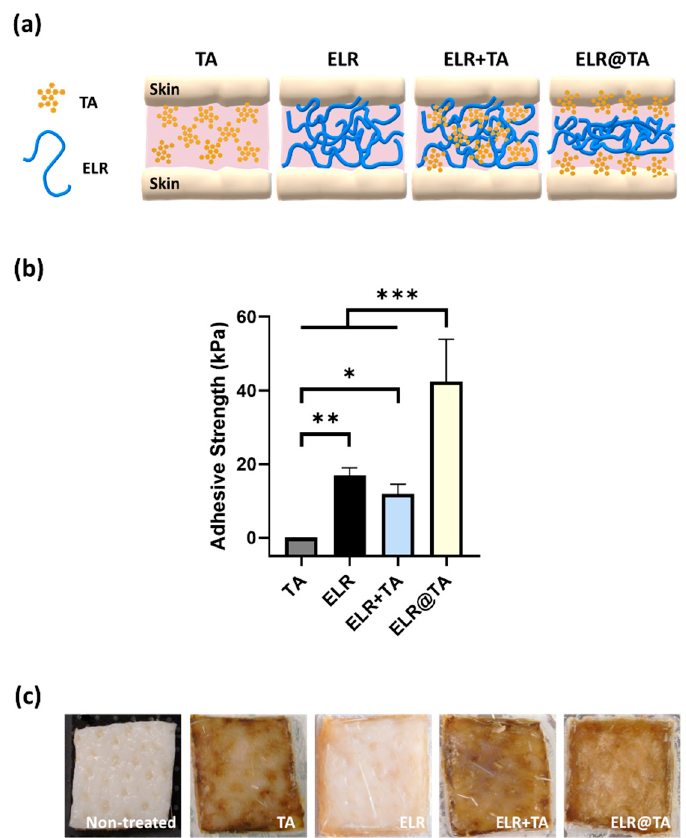
Figure 4. Evaluation of the adhesiveness of ELR-based bioadhesives on skin tissues. ( a ) Schematic representation of ELR-based bioadhesives on skin tissue. ( b ) Adhesive strength on porcine skin of the different formulations (10% TA, 10% ELR, 10% ELR + 10% TA, and 10% ELR @ 10% TA) (* p < 0.05, ** p < 0.01, *** p < 0.001). ( c ) Photographs of the skin before and after testing with the different formulations.